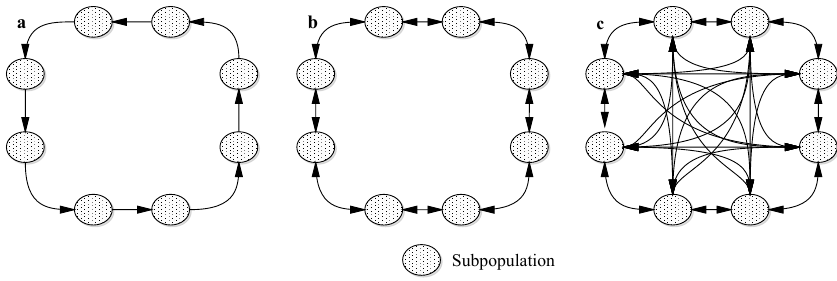
Figure 10. Migration topology of multiple population evolution. ( a ) Ring migration topology; ( b ) Neighborhood migration topology; ( c ) Unrestricted migration